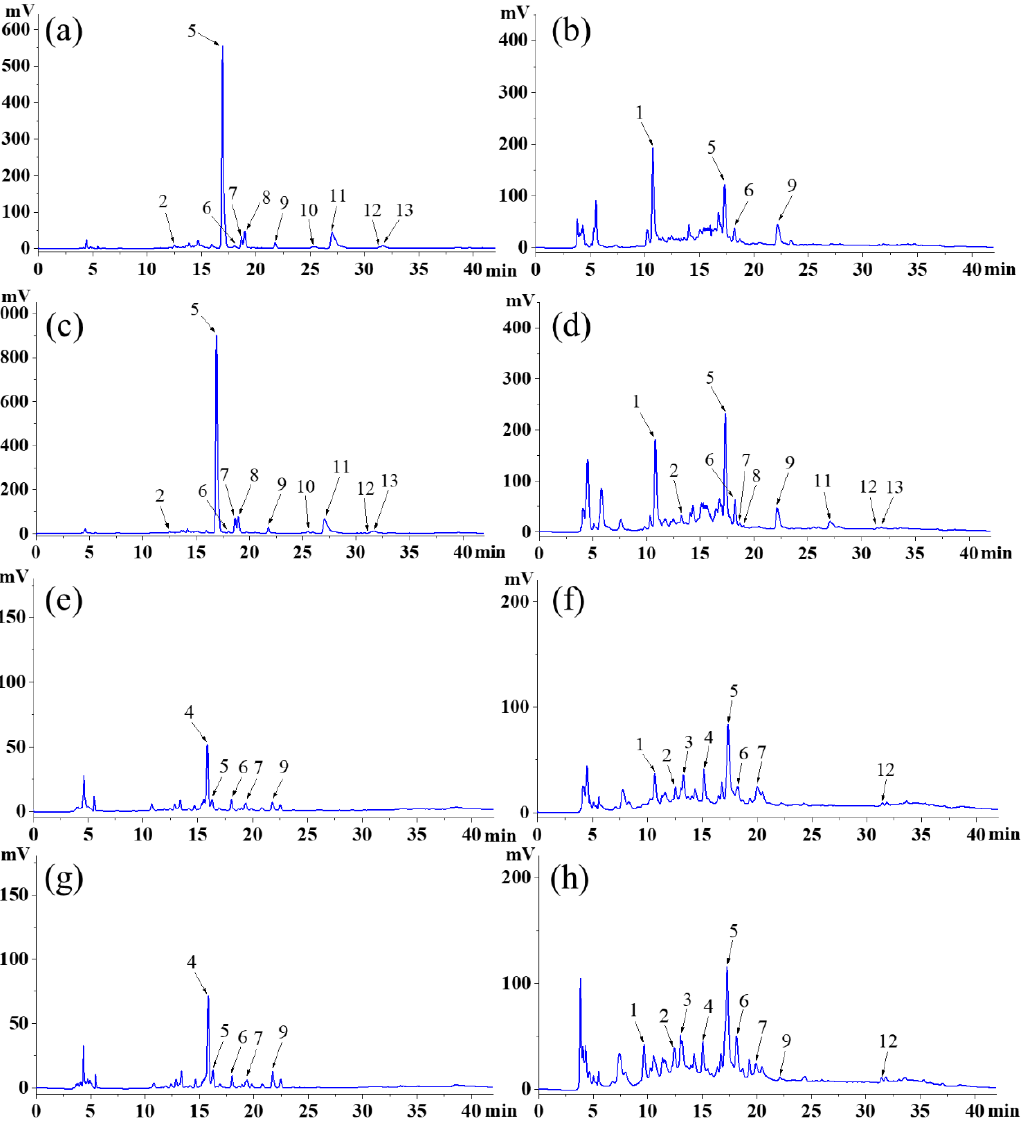
Figure 1. High-performance liquid chromatograms of ( a ) free phenolic compounds of the flower of Sophora japonica L.; ( b ) bound phenolic compounds of the flower of Sophora japonica L.; ( c ) free phenolic compounds of the bud of Sophora japonica L.; ( d ) bound phenolic compounds of the bud of Sophora japonica L.; ( e ) free phenolic compounds of the flower of Robinia pseudoacacia L.; ( f ) bound phenolic compounds of the flower of Robinia pseudoacacia L.; ( g ) free phenolic compounds of the bud of Robinia pseudoacacia L.; and ( h ) bound phenolic compounds of the bud of Robinia pseudoacacia L. The numbers of the peaks in this figure coincide with the compound numbers in Table 6. The chromatograms were recorded at 280